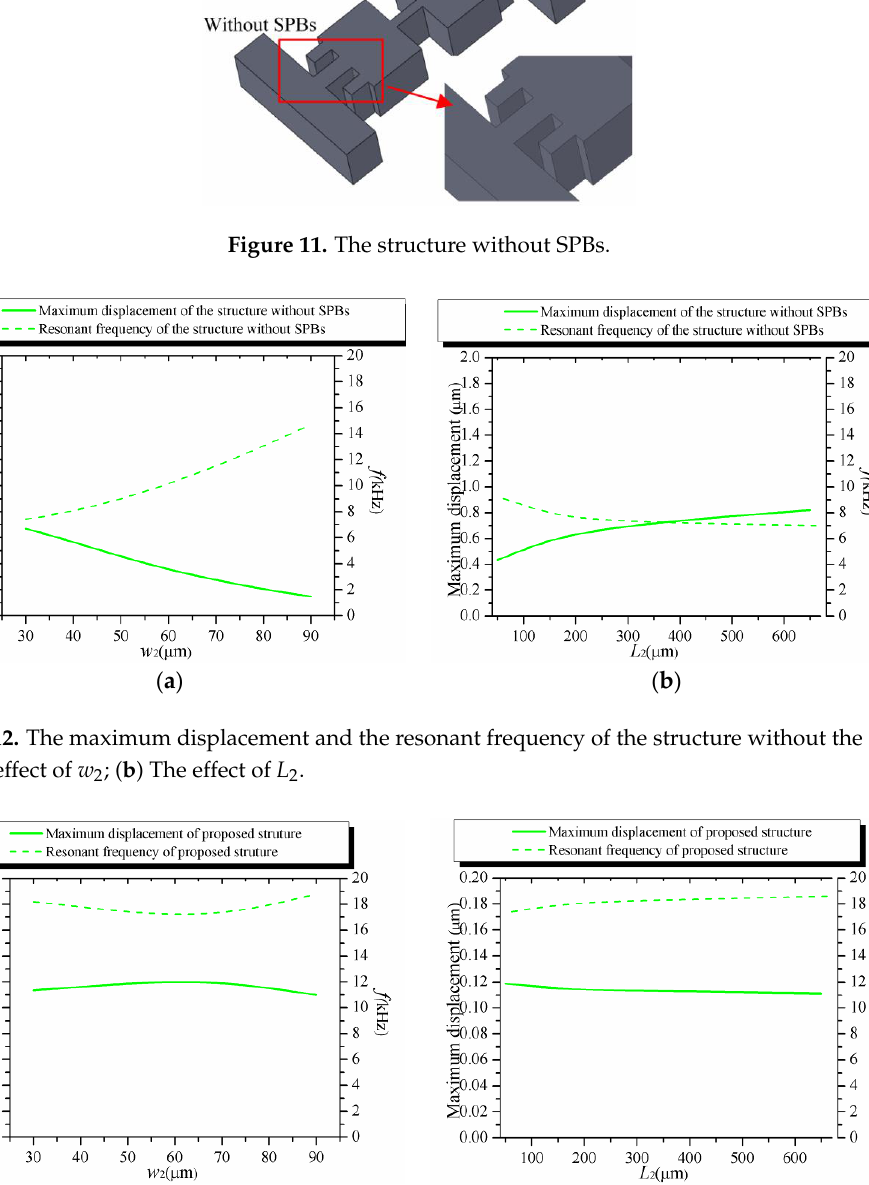
Figure 13. The maximum displacement and the resonant frequency of our proposed structure. ( a ) The effect of w 2 ; ( b ) The effect of L 2 .